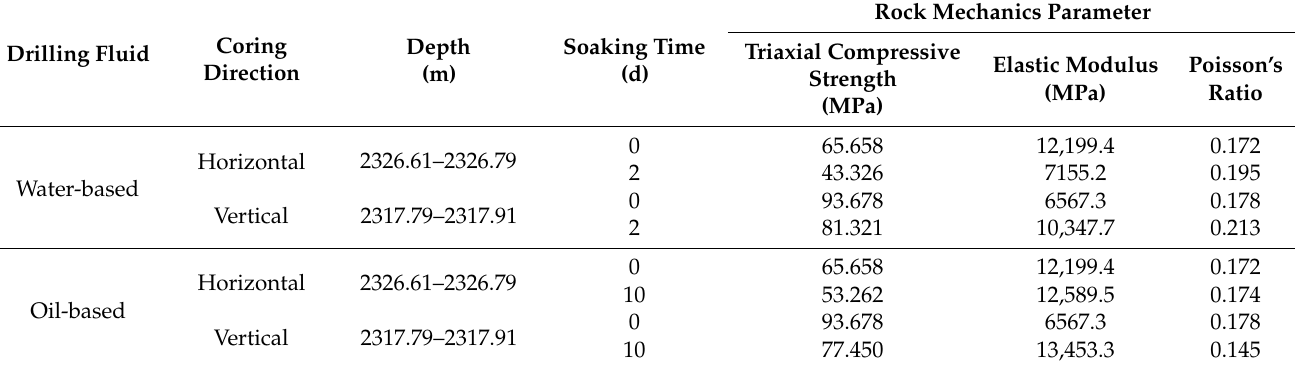
Table 3. Triaxial test results of drilling fluid